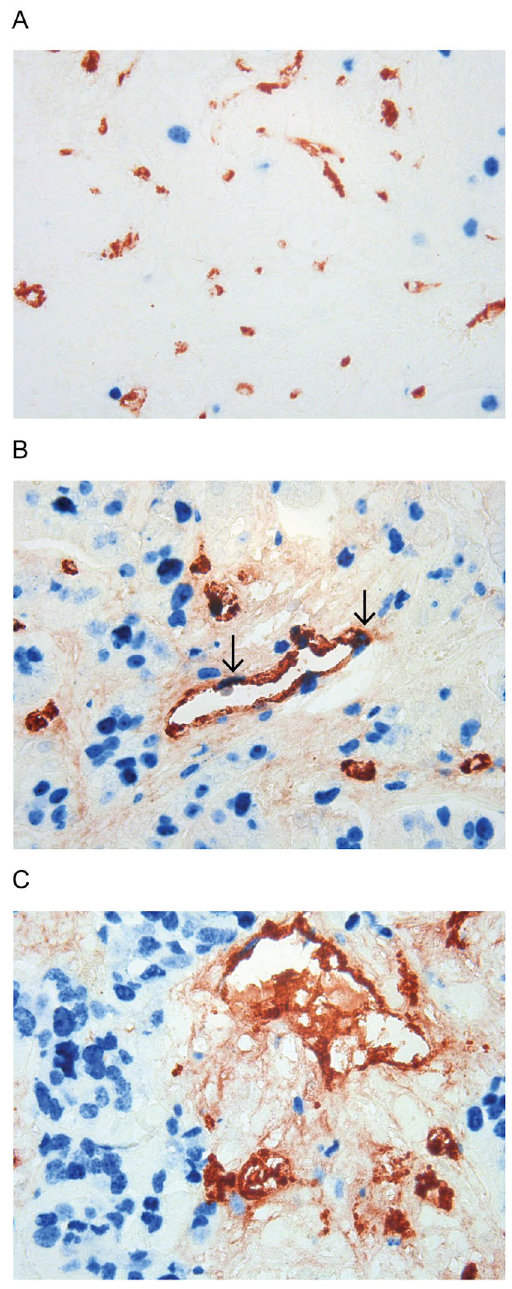
Figure 2. Factor VIII/Ki-67 dual immunohistochemical staining. Combined immunohistochemical staining of Factor VIII (red) and Ki-67 (blue), 400×. ( A ) Factor VIII positive, non-proliferative microvessels (MVD), ( B ) Proliferating microvessels (pMVD) by Factor VIII/Ki-67 co-expression, indicated by arrows, C Glomeruloid Microvascular Proliferation